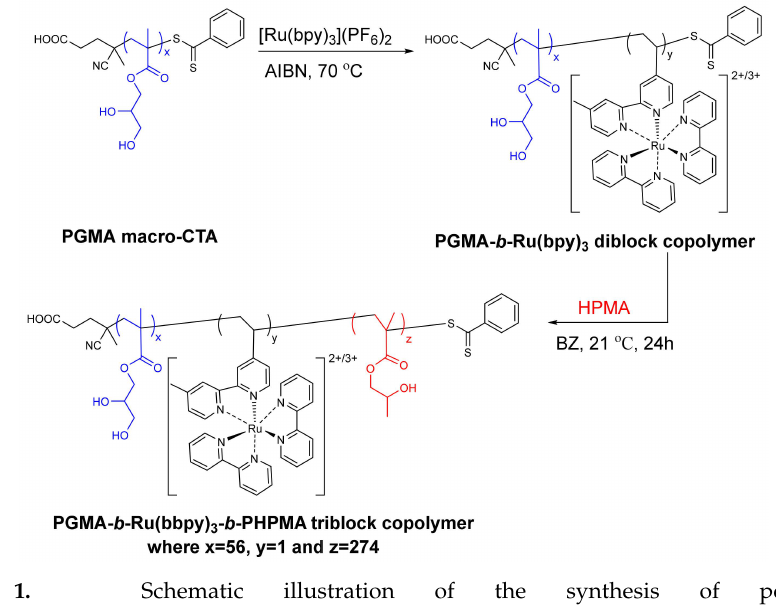
Scheme 1. Schematic illustration of the synthesis of poly(glycerol monomethacrylate)-poly(tris(2,2 (cid:48) -bipyridyl)ruthenium(II)) –poly(2-hydroxypropyl methacrylate) (PGMA- b -Ru(bpy) 3 - b -PHPMA) triblock copolymer